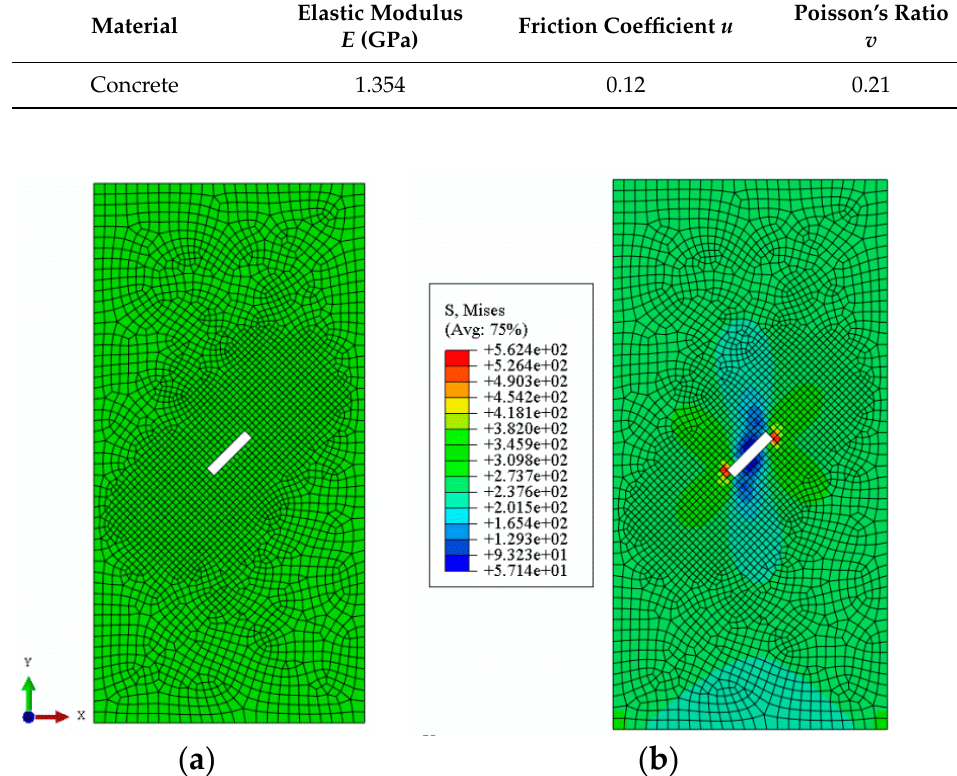
Figure 5. Numerical model of single-crack concrete sample with β = 45° and d = 3.0 mm. ( a ) Numerical model of single-crack sample; ( b ) Stress distribution of single-crack.